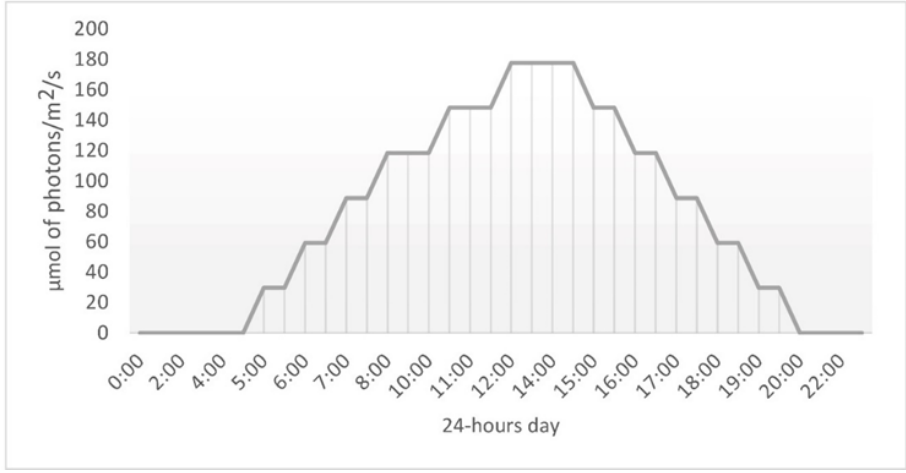
Figure 2. Photosynthetically active radiation in the growing chamber over 24 h (in µmol of photons / m 2 /s).